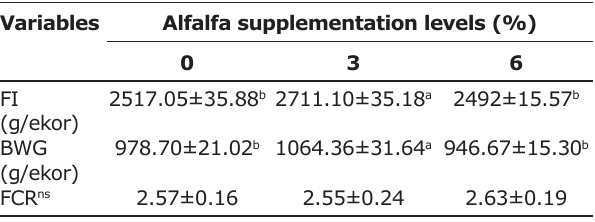
Table-2: The impact of the alfalfa supplementation on the production performance of the hybrid ducks. Variables